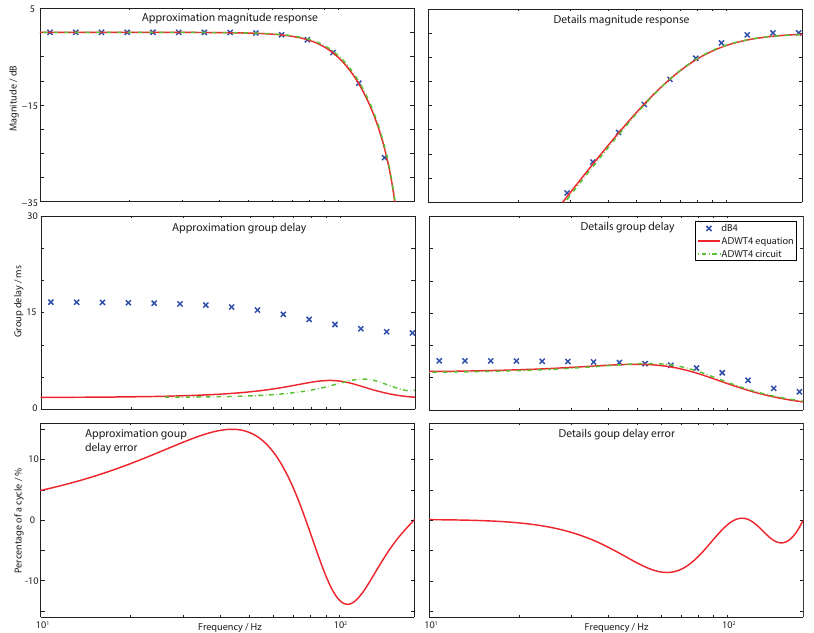
Figure 4. Magnitude, group delay, and group delay error after fixed delay compensation, responses for the DWT and ADWT with base sampling frequency 360 Hz. Fourth order filter Daubechies 4 mother wavelet is shown with passband gain normalized to 0 dB.